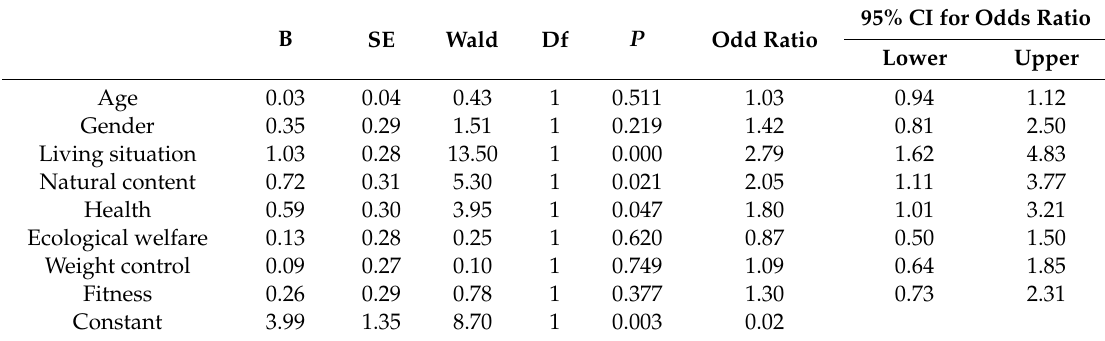
Table 5. The association of demographic characteristics and FCMs with functional food